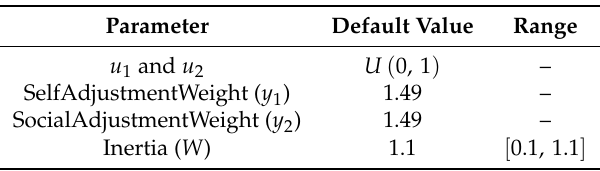
Table A1. PSO default